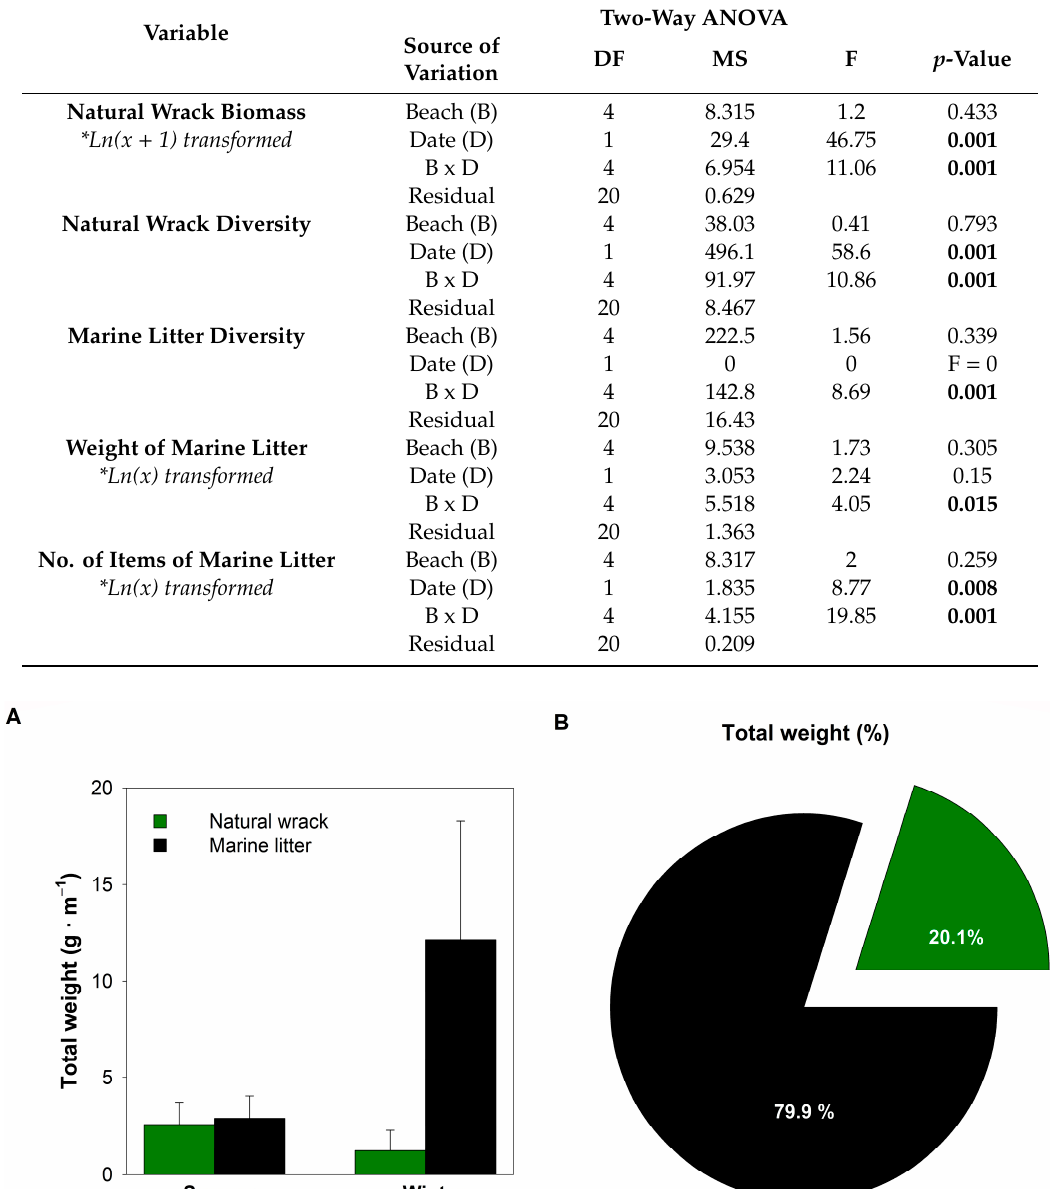
Table 1. Results of the two-way ANOVA analyses of the e ff ects of the beach (Moledo, Â ncora, Cabedelo, Paramos and S ã o Pedro de Maceda) and date of collection (summer and winter) on biomass and diversity of natural wrack and on the diversity of OSPAR categories, weight and number of items of marine litter. Significant di ff erences among treatments are highlighted in bold ( p < 0.01).